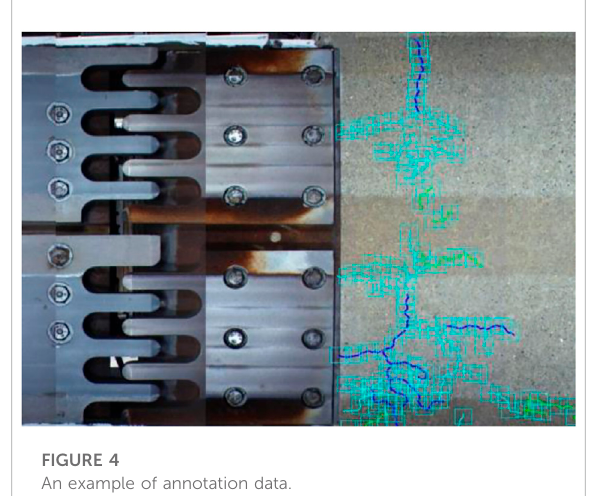
FIGURE 4 An example of annotation data.